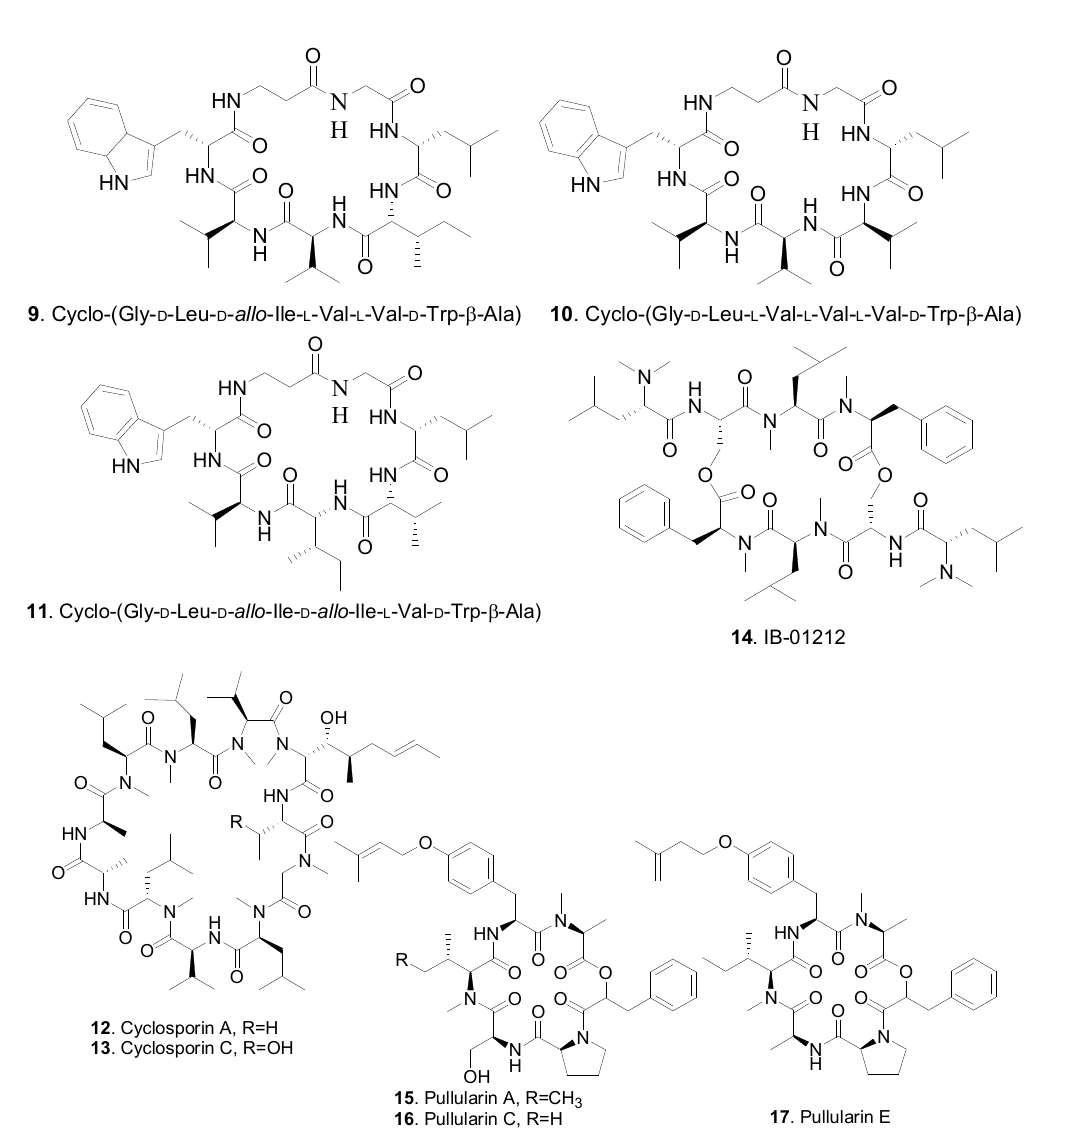
Figure 2. Cyclopeptides isolated from Clonostachys fungi.